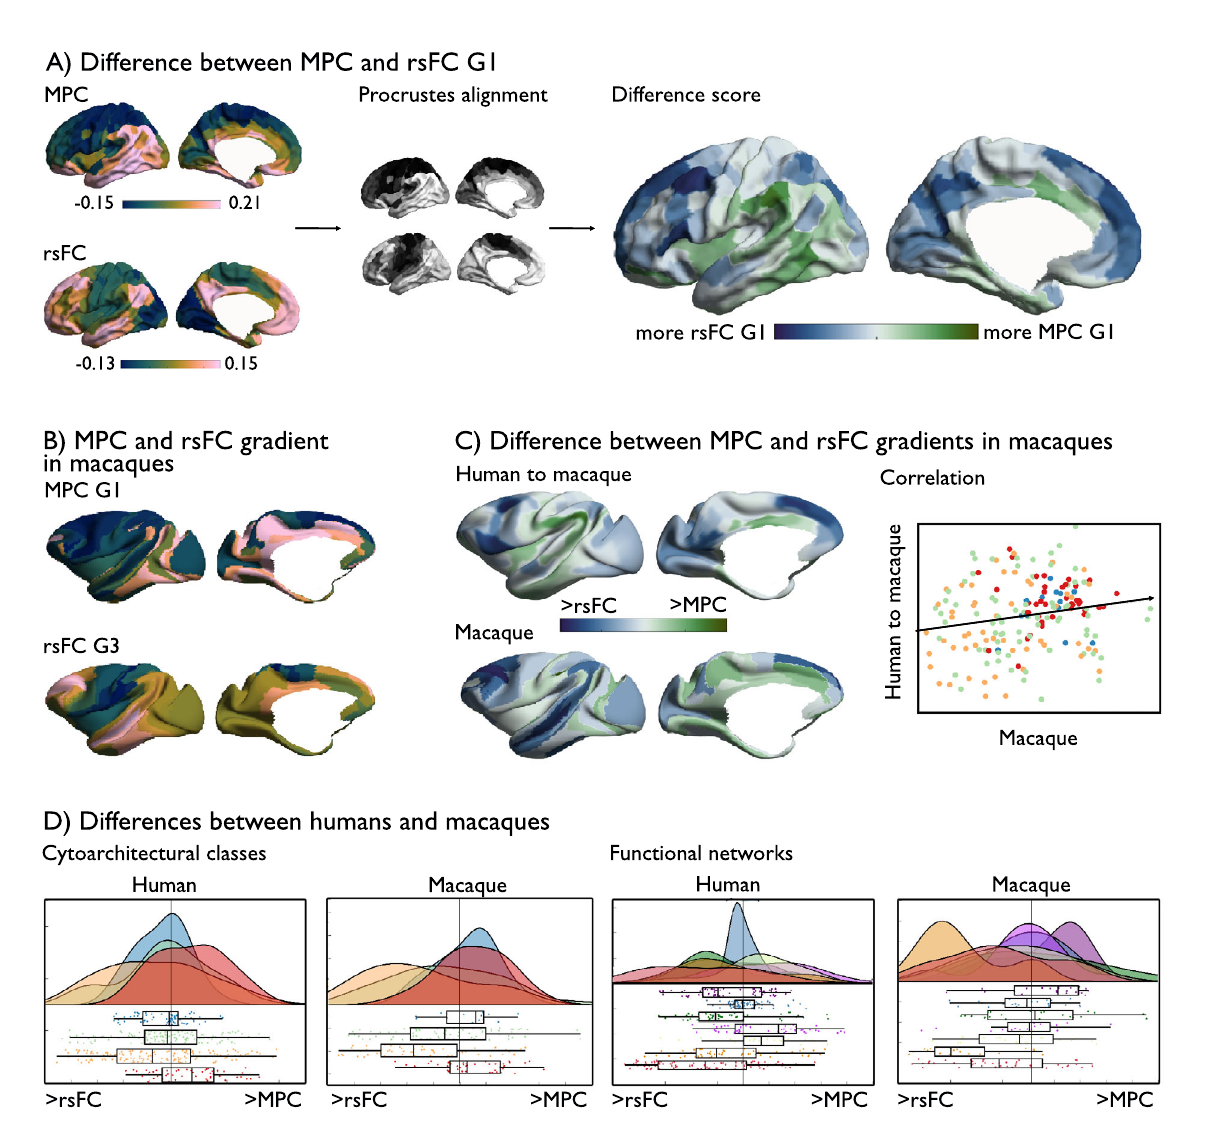
Fig. 6 Difference in organizational gradients of MPC and rsFC in humans and macaques. A Left panel: principal MPC and rsFC gradient; middle panel: alignment; right panel: Δ rsFC-MPCG1 ; B principal gradient of MPC and tertiary gradient of rsFC in macaques; C Difference between principal gradients of MPC and rsFC in humans, mapped to macaque space, and difference between corresponding gradients in macaques (lower panel); right: correlation between human and macaque maps; D Raincloud plots of organizational differences as a function of cytoarchitectural class 59 , and functional networks 28 in humans (400 parcels, Schaefer parcellation) and macaques (182 parcels, Markov parcellation), boxes show the median and interquartile (25 – 75%) range, whiskers depict the 1.5*IQR from the quartile. Source data are provided as a Source Data fi